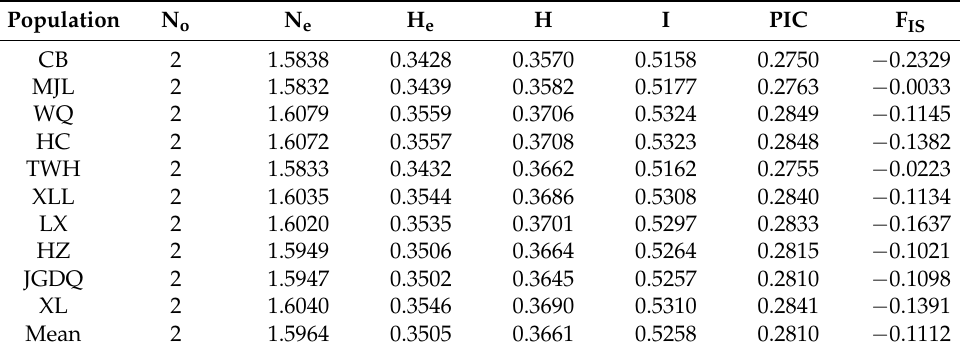
Table 3. Genetic diversity of the ten Chosenia arbutifolia populations.